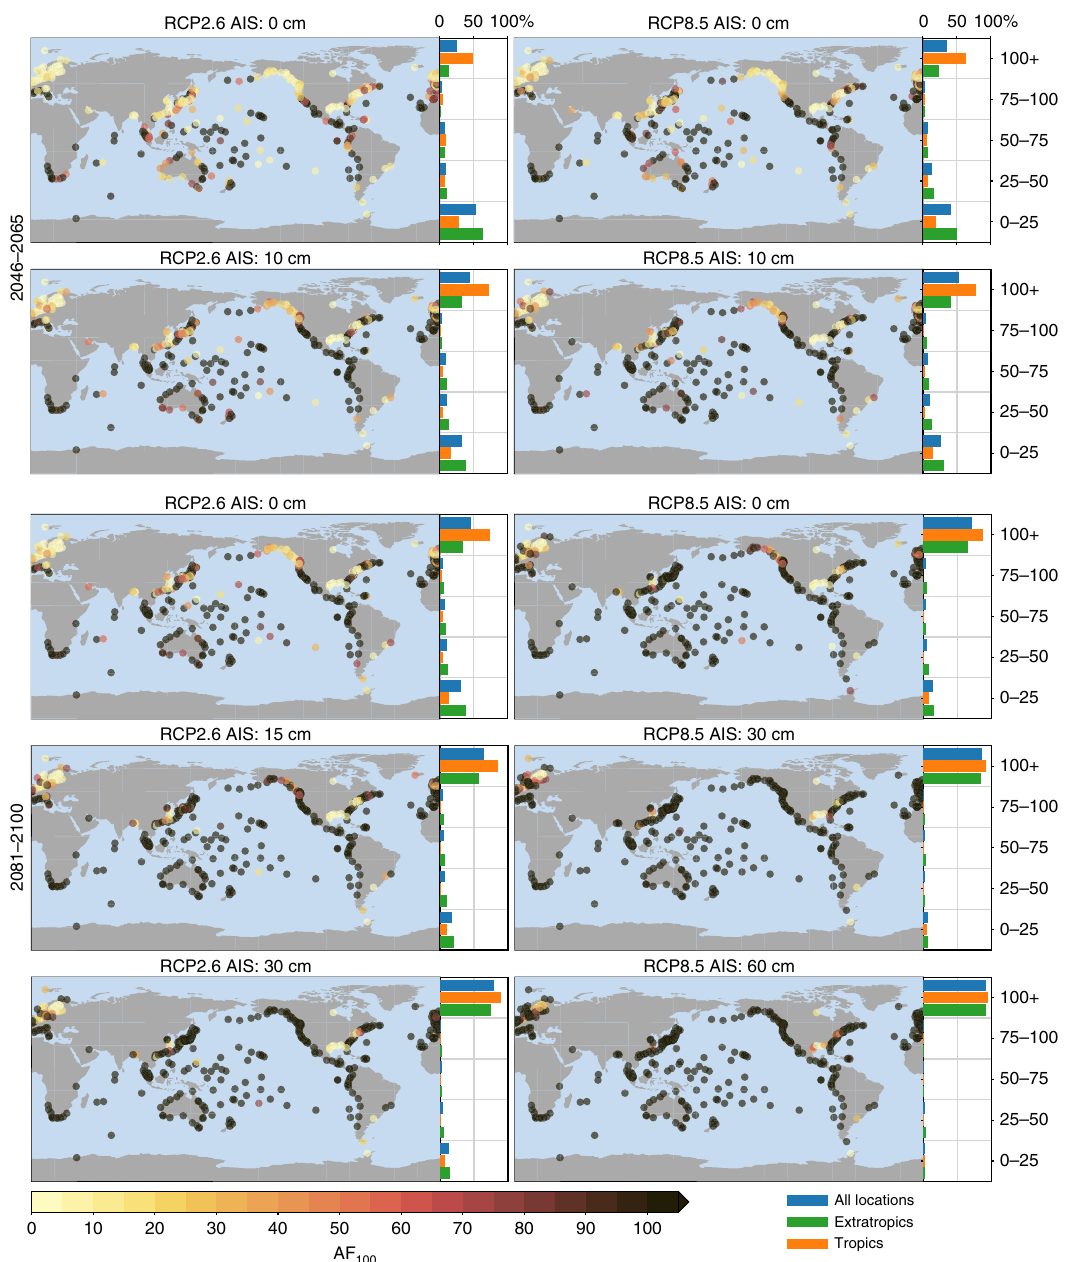
Fig. 4 Frequency ampli fi cation factors for the 100-year extreme sea-level event. The bars on the right show the histogram of the AFs, separated into stations in the tropics (latitude between ±23.44°), extratropics (latitude outside ±23.44°), and all stations. See Supplementary Figs. 6 and 7 for the frequency ampli fi cation factors for all scenarios and AIS